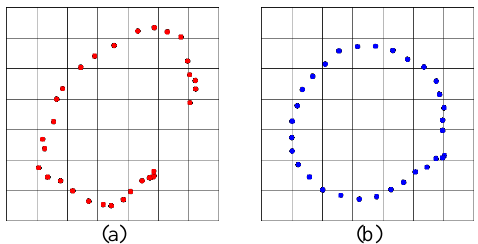
Figure 2 . Horizontal camera positions: (a) as measured by the camera GPS, in red, and (b) after the SfM adjustment, in blue. Figure 3 shows the generated dense point cloud and the measurement of a check distance of 1 meter. In the point cloud that distance showed up with an excess error of 30%. That